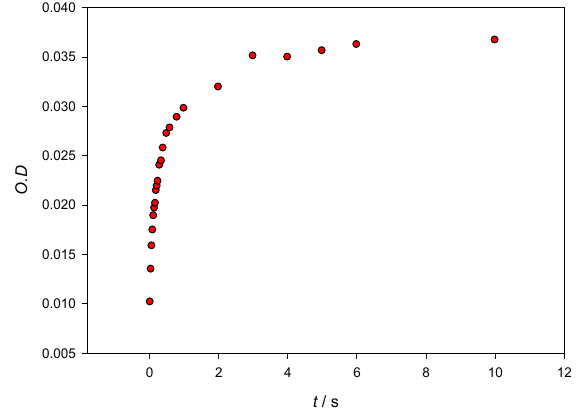
Figure 8. Optical density changes at λ = 565 nm versus time when mixing 10 nm AuNPs with Lys. Concentrations in the stopped flow cuvette are [AuNPs] = 3.28 × 10 − 9 M and [Lys] = 10 − 7 M.